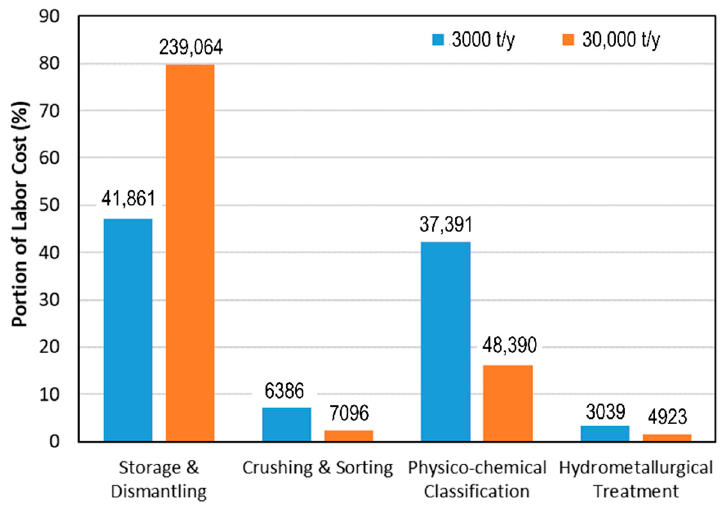
Figure 7. Labor cost breakdown among the different process sections. The numbers on the histogram bars represent the total hour of labor hours required per year.